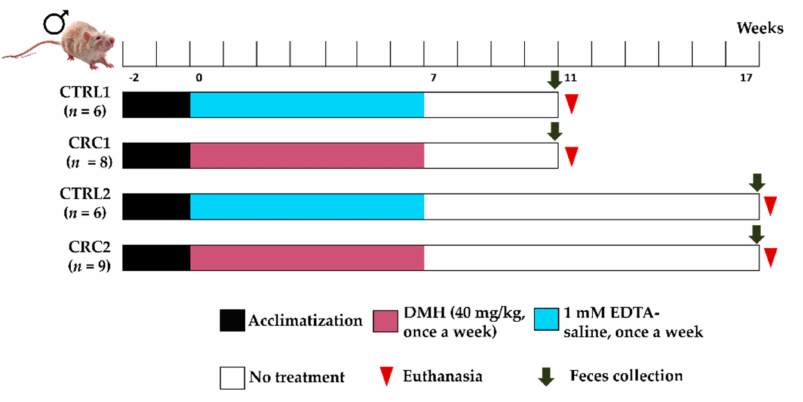
Figure 1. The experimental protocol implemented for the study of DMH-induced